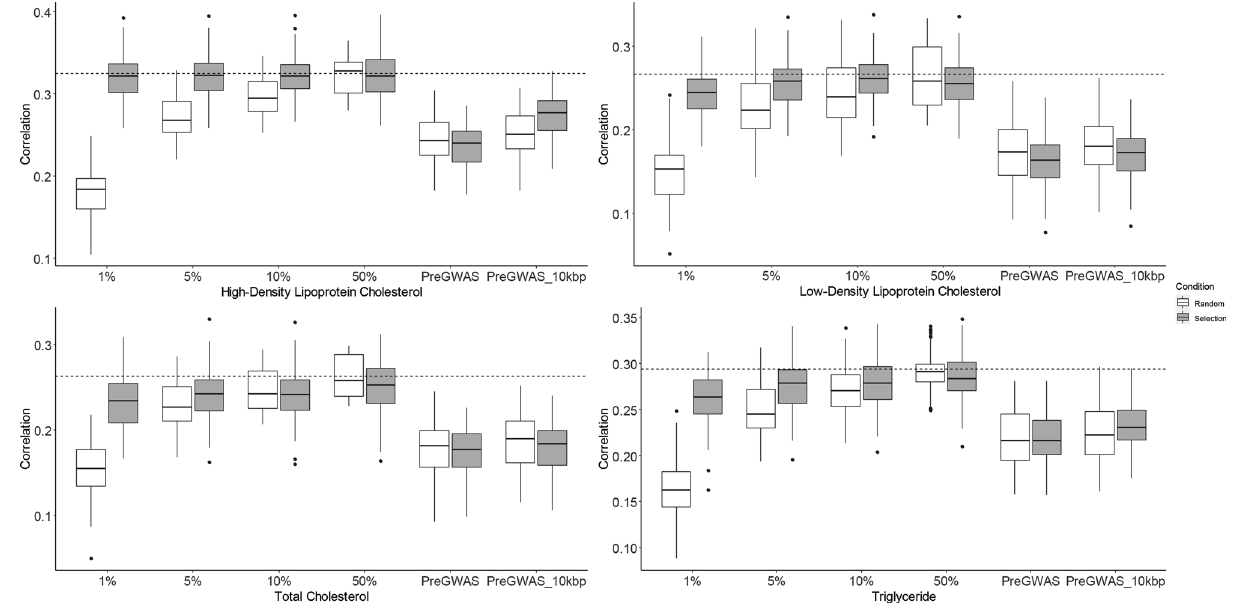
Figure 1. Distribution of CV-correlation between genetic prediction and adjusted phenotypes for HDL-C, LDL-C, TC, and TG. The average CV-correlation result based on tenfold 10-repeat between genetic prediction and adjusted phenotype (for age, sex, and BMI) is reported as the accuracy index. The dashed lines show the Prediction Accuracy obtained from the entire SNPs’ inclusion, which is almost the highest accuracy in most cases. The black boxes show the distribution of the tenfold 10-repeat cross-validation accuracy of selected SNPs based on proposed approaches. The gray boxes show the distribution of accuracy of the same cross-validation setting for the subsets of corresponding equally randomly selected SNPs. Subsets of the top 1%: 1% of the entire SNPs with the lowest p-value; Subsets of the top 5%: 5% of the entire SNPs with the lowest p-value; Subsets of the top 10%: 10% of the entire SNPs with the lowest p-value; Subsets of the top 50%: 50% of the entire SNPs with the lowest p-value; preGWAS: reported associated SNPs extracted from GWAS Catalog database; preGWAS_10kbp: within the identified genes and ± 10 kbp extended at both sides of the genes to control regulatory regions. All correlation coefficients were significant (< 0.000001). The highest prediction accuracy (dashed lines) was achieved when the entire SNPs were included for each trait. The lowest prediction accuracy was also achieved for each trait when subsets of associated SNPs from previous GWAS were used. For the first two subsets (1% and 5%), selected SNPs’ accuracy is substantially more than random SNPs selected. Comparing the prediction in HDL-C, LDL-C, TC, and TG based on the GWAS subsets, the top 50% GWAS SNPs show the highest prediction each repeated fold (10-repeated tenfold) for different subset selections. It showed that almost half of the shared SNPs are in the intronic region of genes for each of the lipid profile traits, HDL-C (55.65% for top 1% SNPs, and 56.89% for top 50% of the SNPs), LDL-C (51.34% for top1% and 57.44% for top 50% of SNPs), TC (54.76% for top 1% of SNPs and 57.31% for top 50% of SNPs), and TG (54.74% for top 1% of SNPs and 57.48% for top 50% of SNPs). The second-highest number of the shared SNPs are in intergenic regions, as the annotation in the case of the top 1% of SNPs, is 18.34% for HDL-C, 22.63% for LDL-D, 18.33% for TC, and 18.95% for TG. However, the lowest number of SNPs are for the non-coding regions, as in HDL-C, the number of shared SNPs is 1.92% for the first subset (top 1%), 1.22% for LDL-C, 0.7% for TC, and 1.47% for TG. For each trait, we selected the 100 most significant SNPs with a p-value from 1.45e−110 to 5.12e−06, in which some SNPs are common between traits. These variants for four traits included 306 unique SNPs and 81 related genes. Readers can find out more detailed information about these genes in Supplementary File 2.xlsx. Based on the GWAS catalog database 5 , they were associated with 2387 traits, and more than 50% of them (1244 traits) are reported to be associated with lipid profile traits.